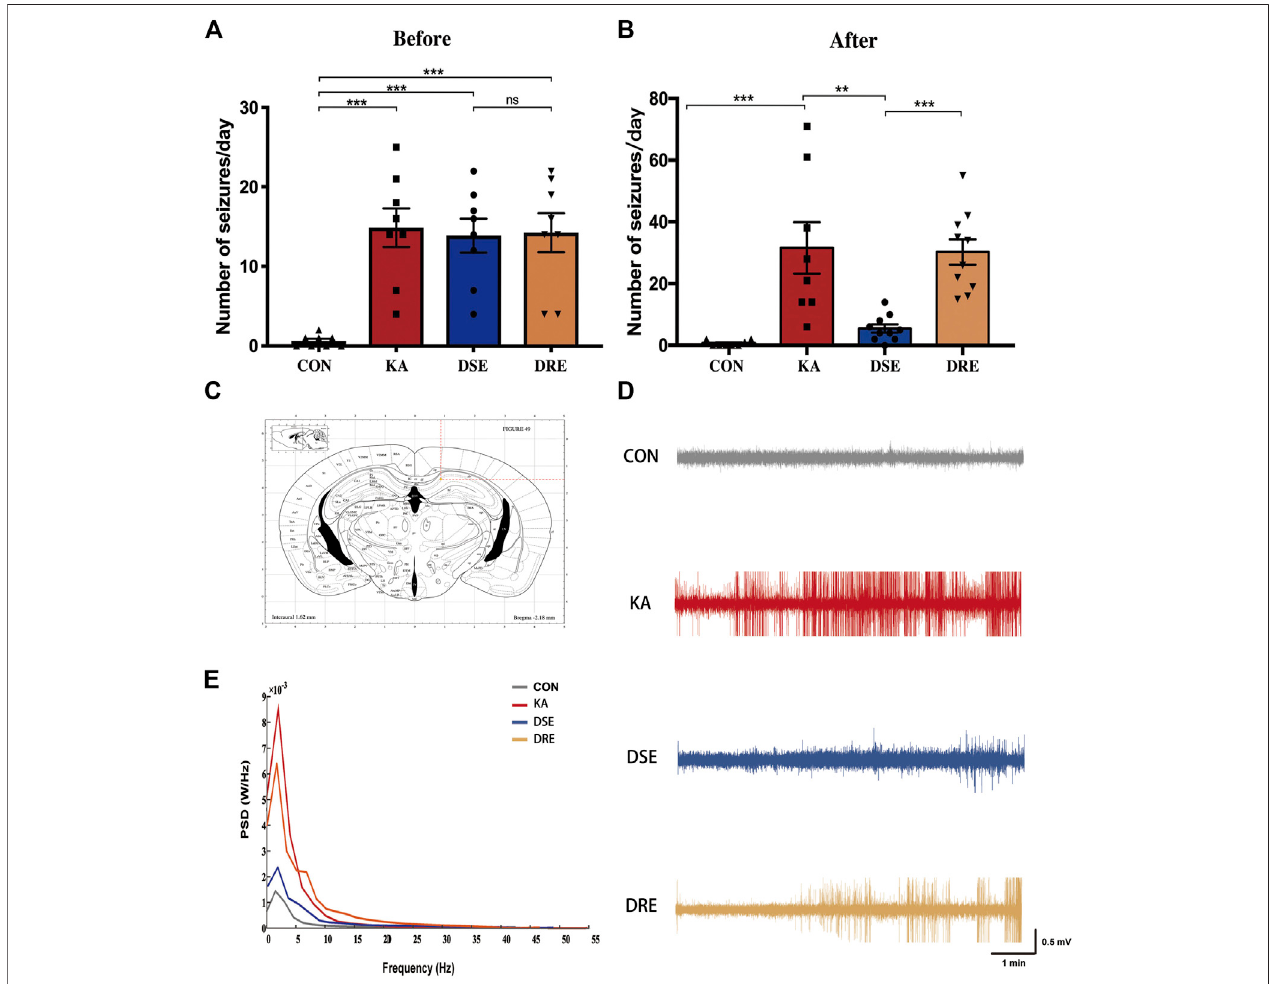
FIGURE 2 | Data of EEGs and behavior in mice with KA-induced epilepsy ( n (cid:1) 12). (A) There is no obvious difference in number of seizures in mice with VPA- sensitive epilepsy and VPA-resistant epilepsy group before VPA administration. (B) After VPA administration, mice with VPA-resistant displayed increased seizure severity when compared to mice with VPA-sensitive epilepsy. (C) Location of EEG electrodes in mouse hippocampus: AP: − 2.2 ± 0.1 mm, ML: +0.8 ± 0.1 mm, DV: − 1.4 ± 0.1 mm. (D) The fi eld potential signal from mice in control, epilepsy model, VPA-sensitive epilepsy, and VPA-resistant epilepsy groups. (E) Representative EEGs showing typical epileptiform discharges in mice with VPA-resistant epilepsy. (F) The power spectral density of delta band of the VPA-resistant group was higher than that of the VPA-sensitive group. Values are the mean ± S.D. Unpaired t -test. * p < 0.05, ** p < 0.01, and *** p < 0.001. ns, not signi fi cant. CON: control, KA: KA- induced epilepsy, DSE: VPA-sensitive epilepsy, and DRE: VPA-resistant epilepsy.